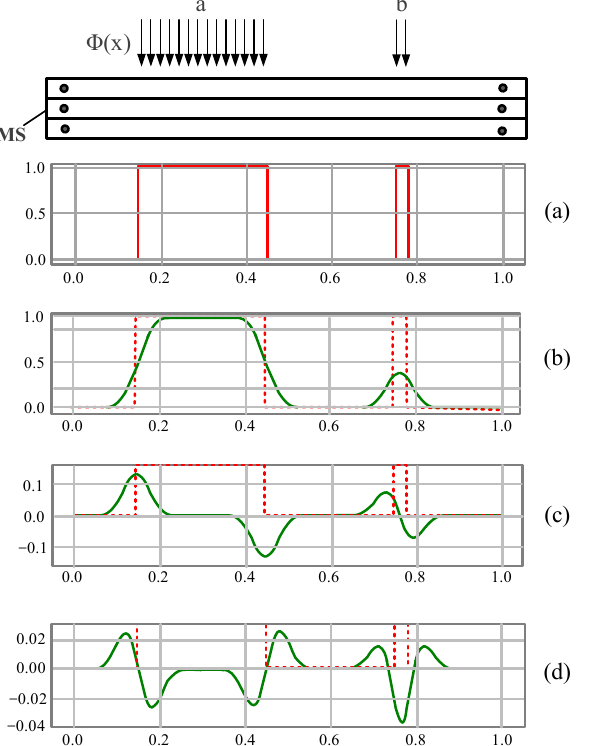
Figure 4. Timing diagrams illustrating the operation of a noise-proof multiscan-based measuring device. ( a ) the action f ( ˆ x ) is the profile of the light zone; ( b ) the response V ( ˆ t ) is the MOD video signal (solid line); ( c , d ) illustrate the stages of the conventional processing of the video signal with the use of its first and second derivatives.